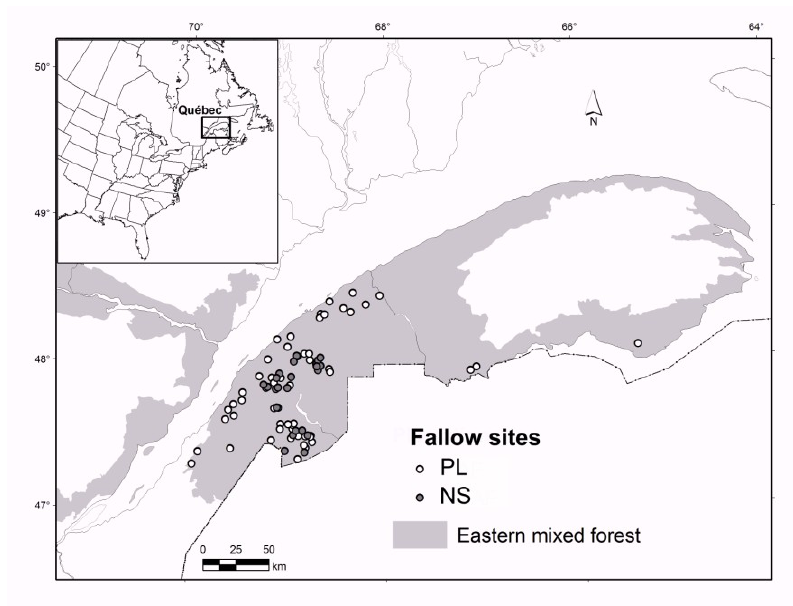
Figure 1. Location of plantation (PL) and natural succession (NS) established on fallow lands and sampled in the Bas-Saint-Laurent region in eastern Quebec,